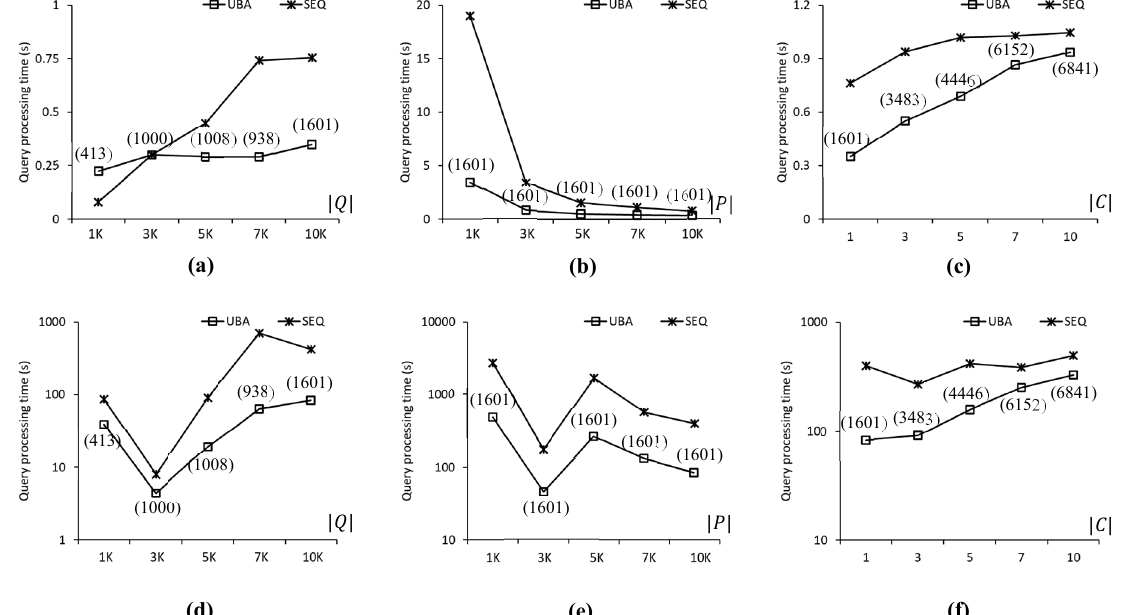
Figure 8. Comparison of query processing times for the FLA roadmap: ( a ) 1 K ≤ | Q | ≤ 10 K. ( b ) 1 K ≤ | P | ≤ 10 K. ( c ) 1 ≤ | C | ≤ 10. ( d ) 1 K ≤ | Q | ≤ 10 K. ( e ) 1 K ≤ | P | ≤ 10 K. ( f ) 1 ≤ | C | ≤